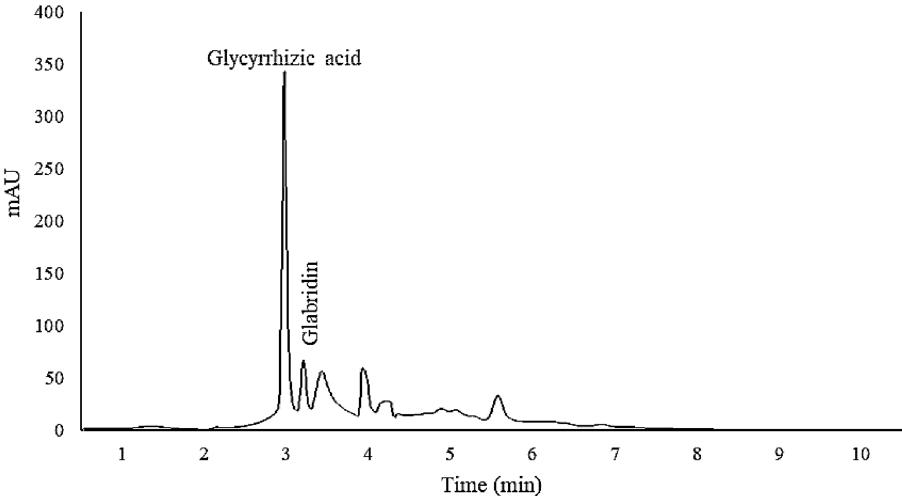
Figure 3. The HPLC chromatogram of Glycyrrhizic acid and Glabridin from one of the studied accessions (Baft